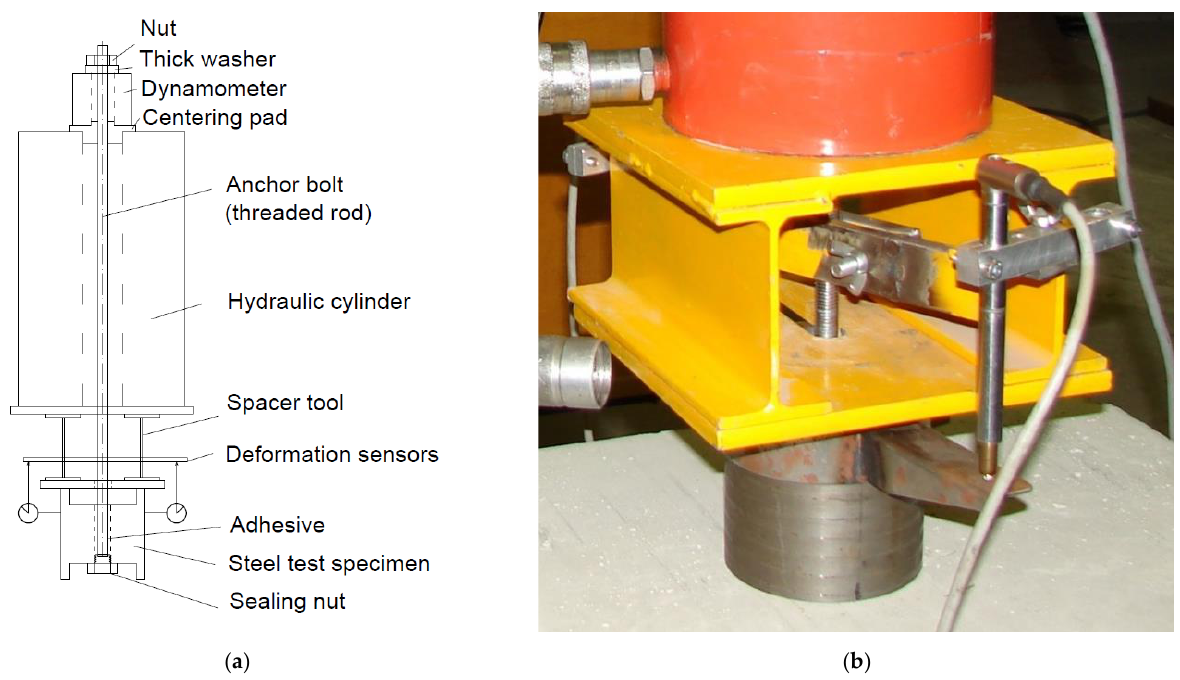
Figure 5. ( a ) Scheme of the test; ( b ) Detail of the deformation sensors installation.